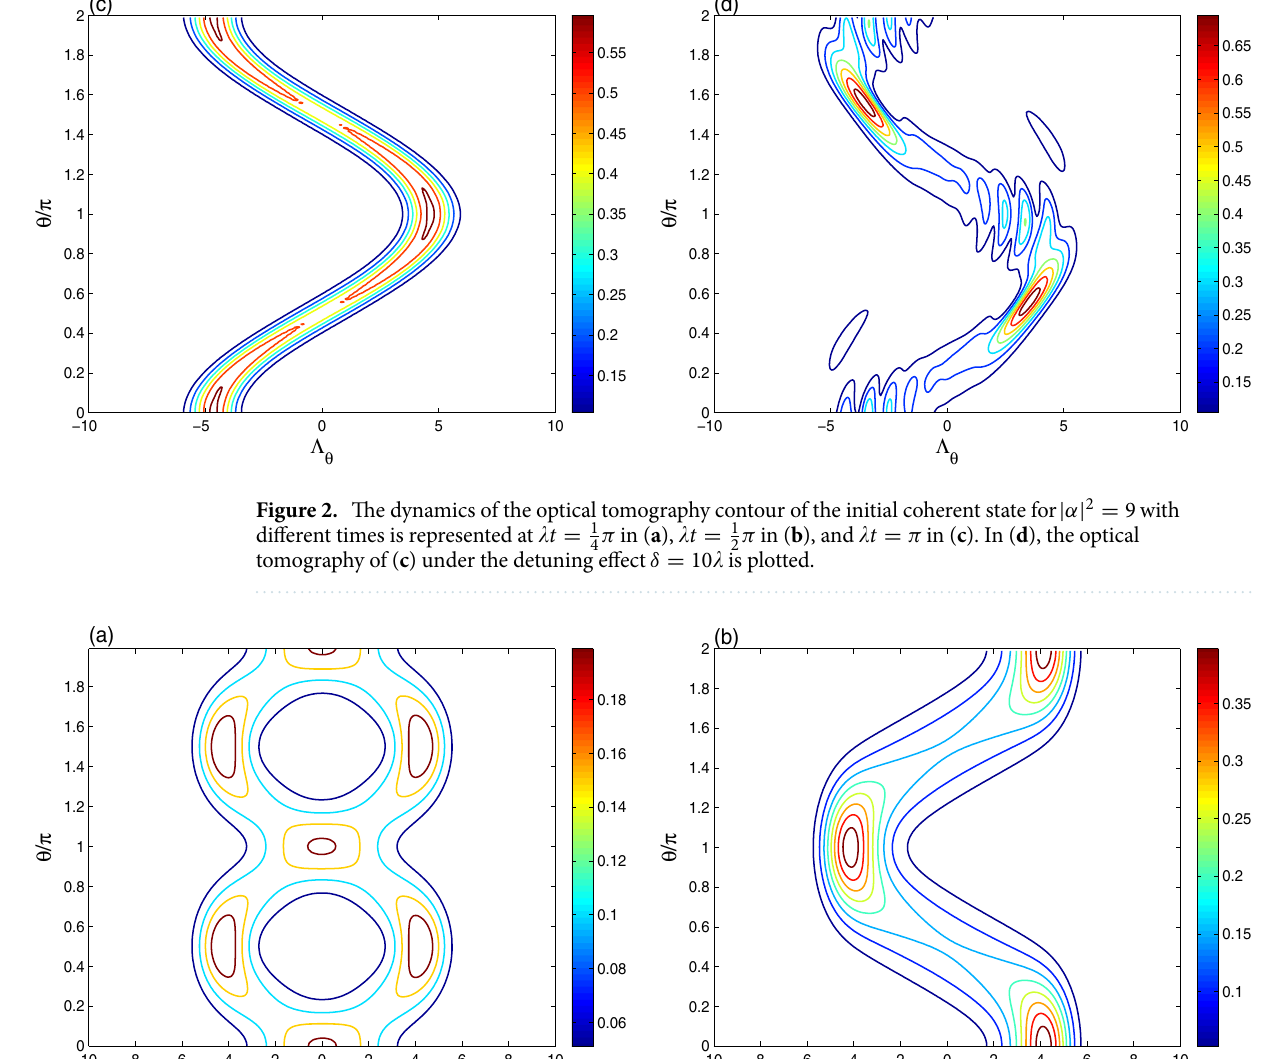
Figure 3. The effect of the intrinsic decoherence is illustrated on the optical tomography dynamics of the Fig. 2b,c for γ = 0.05 (cid:31)